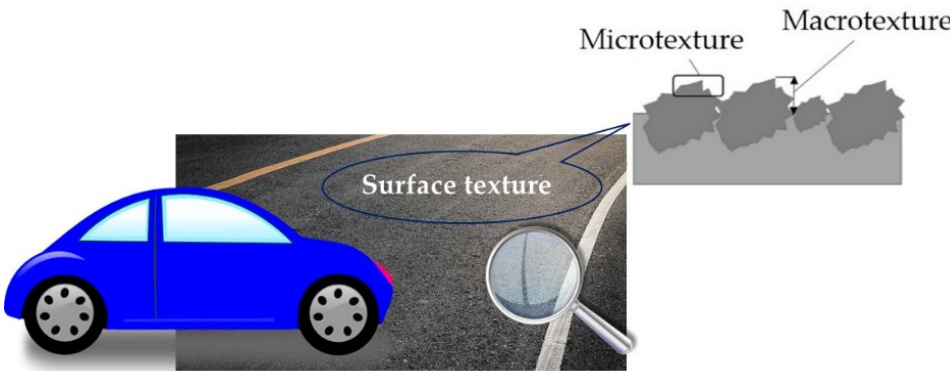
Figure 4. Illustration of pavement texture components.